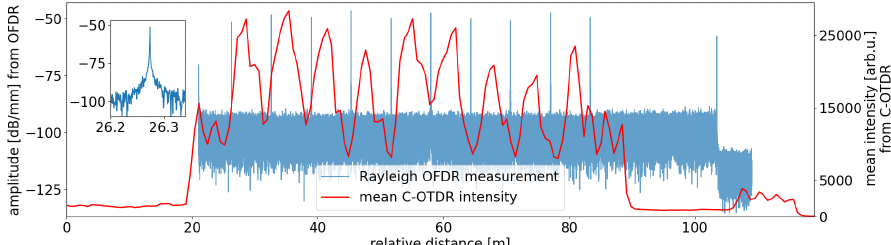
Figure 4. Backscatter profile of utilized sensing fiber from Luna OFDR measurement (blue line) and averaged C-OTDR intensity with a selected interrogator pulse width of 10 m. The inset shows a zoomed view upon a single scattering dot.